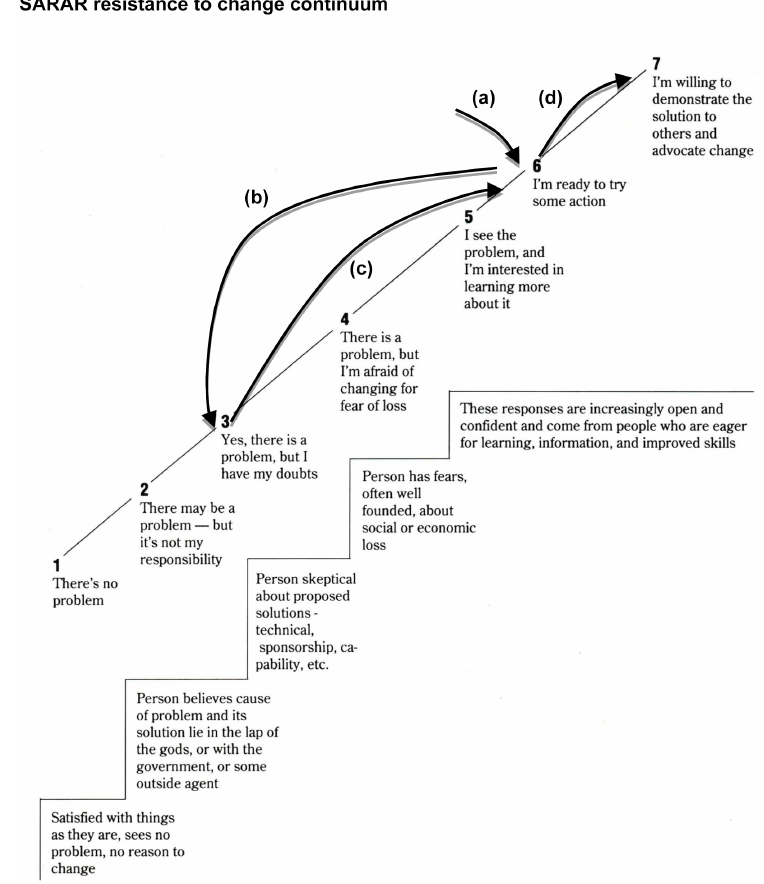
Figure 4. The implemented intervention based on the scale of community participation of Srinivasan (1990).